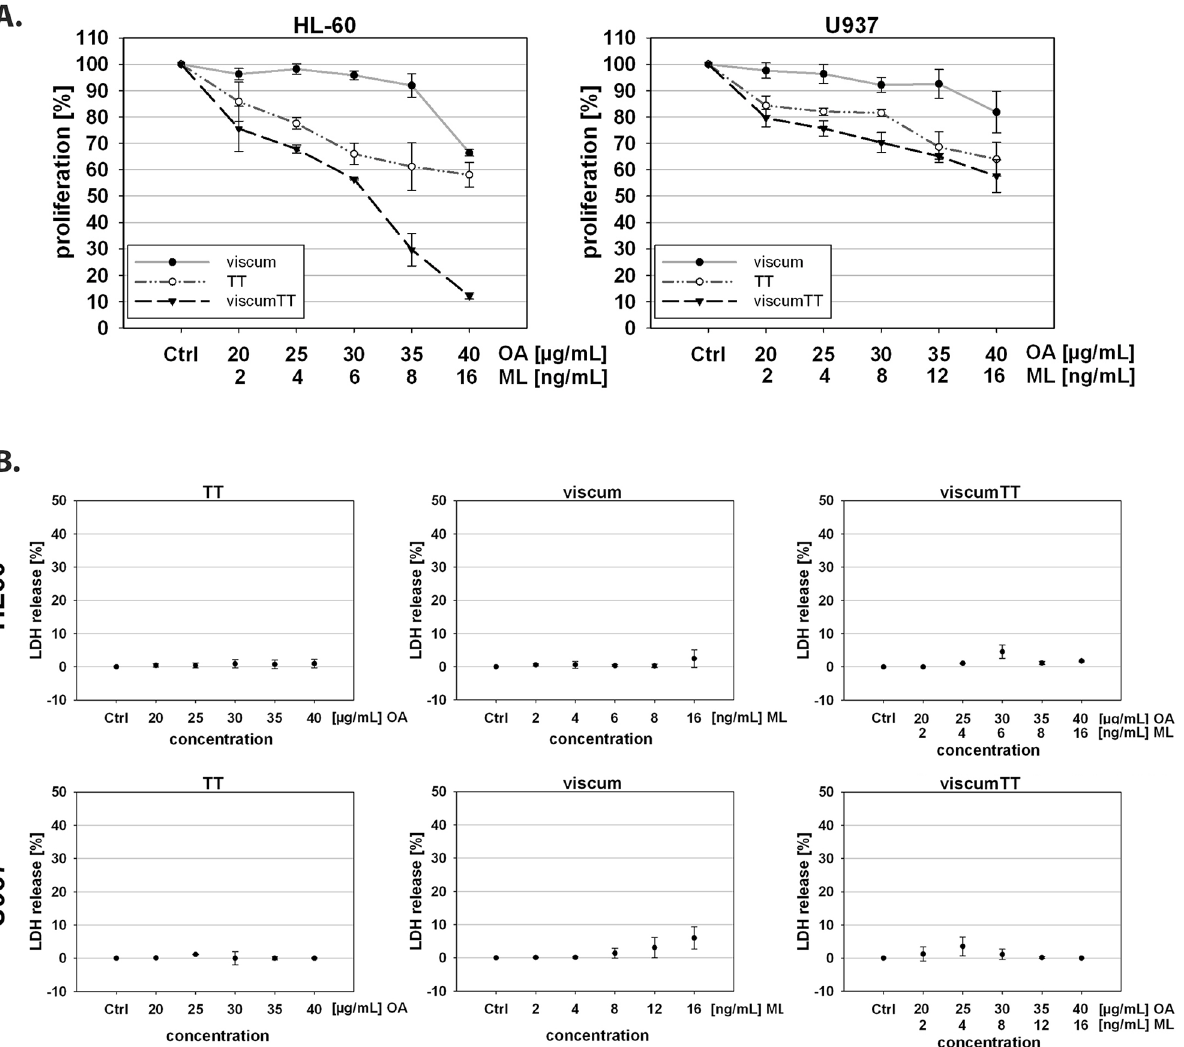
Fig 1. Effects of VAE on viability and proliferation rate of U937 and HL-60 cells. A. U937 and HL-60 cells were incubated with increasing doses of VAE (TT, viscum or viscumTT) for 18 h. Proliferation was measured by the CASY Cell Counter System. VAE treated cells show a dose-dependent inhibition of proliferation (n = 3). B. U937 and HL-60 cells were incubated with increasing concentrations of VAE (TT, viscum or viscumTT) for 2 h. Cell viability was measured by LDH release assay. The results are expressed as a percentage of control ± SD (n = 3). There was no relevant LDH release ( < 10% compared to